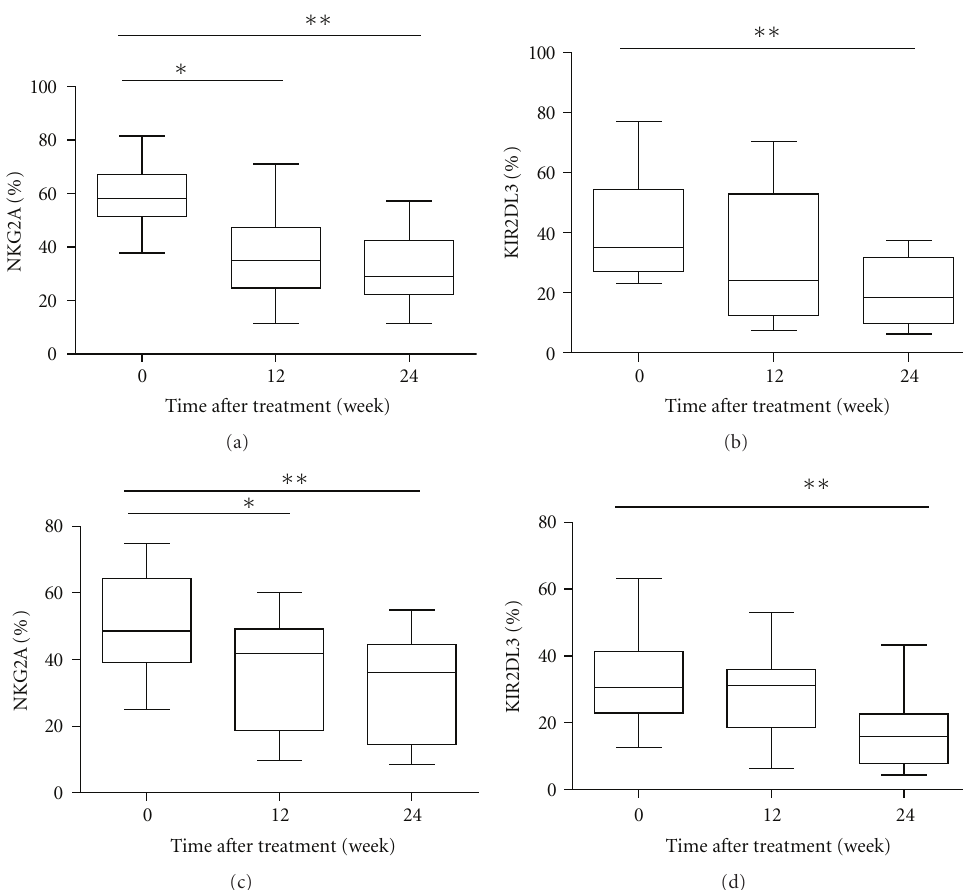
Figure 6: Antiviral treatments results in decrease of NKG2A and KIR2DL3 expression in patients with chronic HBV infection treated with tenofovir or adefovir. The frequency of NKG2A and KIR2DL3 expressing NK cells at baseline (0w), 12 w, and at 24w of therapy. Data are shown in box-and-whisker plots (a)–(d). (TDF-group (a) (b)): changes in the frequency of inhibitory receptor + NK cells; (ADV-group (c) (d)): changes in the frequency of inhibitory receptor + NK cells.